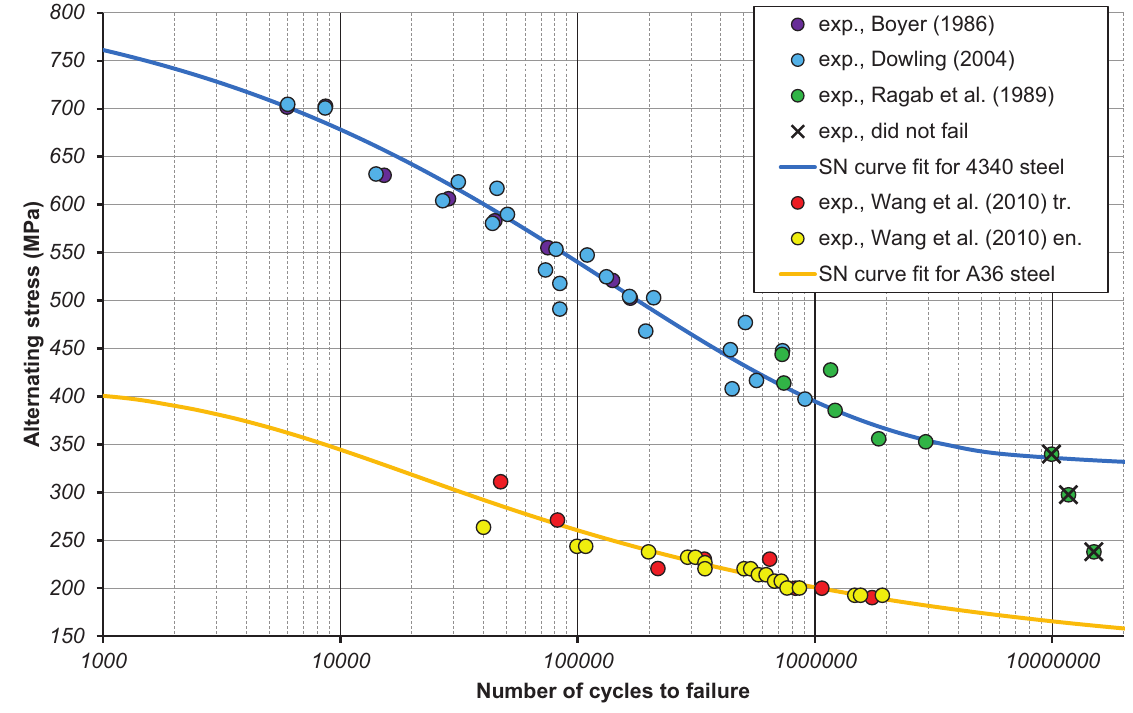
Figure 3: S-N curve fits of ASTM A36 steel based on HCF data by [31] and AISI 4340 steel based on HCF data by [32], [33] and [34]